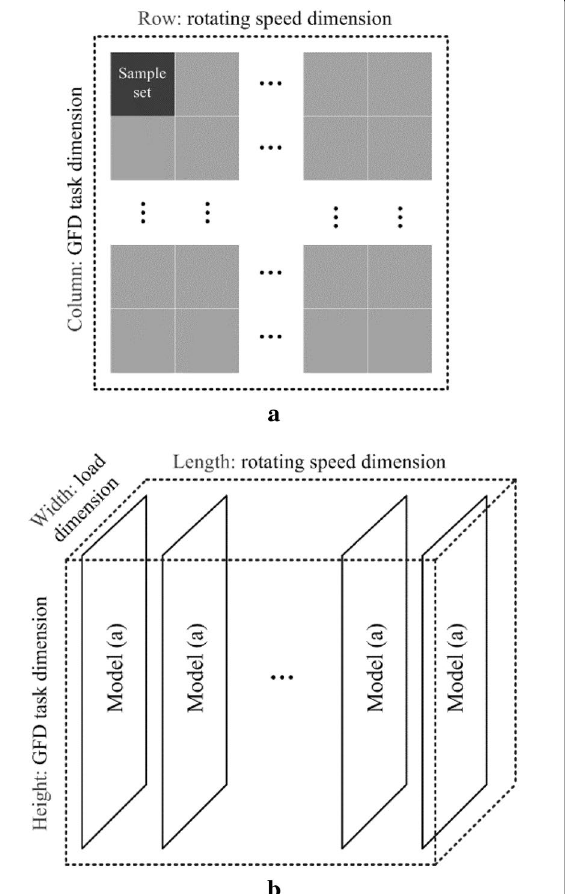
Figure 2 High dimension gear fault diagnosis models: a the 2D classification matrix; b the 3D classification